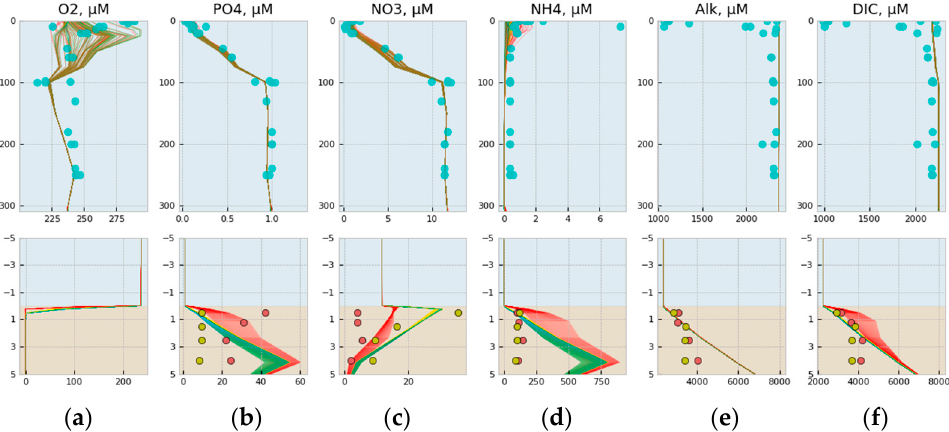
Figure 6. Modeled and observed vertical distribution of dissolved oxygen ( a ), phosphate ( b ), nitrate ( c ), ammonium ( d ), total alkalinity ( e ), and dissolved inorganic carbon ( f ), in the water column and porewater. Light blue circles show concentrations observed at 300–1000 m distance from a farm in the water column at stations 1–7. Red and yellow circles show sediment porewater concentrations observed at 100 and 500 m from a farm (stations 200 and 199, respectively). All samples were taken in August. Colored lines show the distributions of modeled concentrations in the time interval ± 1 month relative to observations (bottom) for di ff erent distances from a farm: 100 m (red), 500 m (yellow), 1000 m (green), and 1500 m